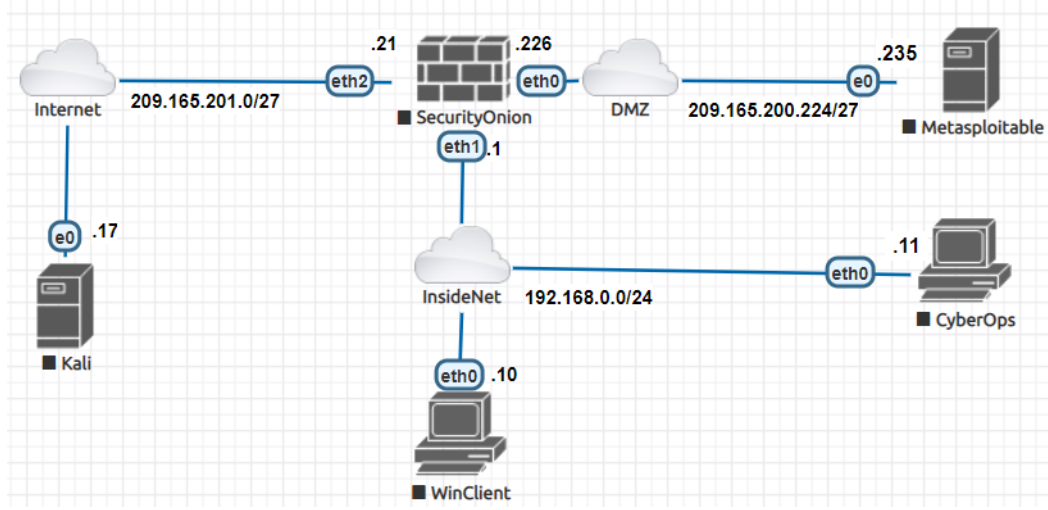
Figure 25: Presentation of paper